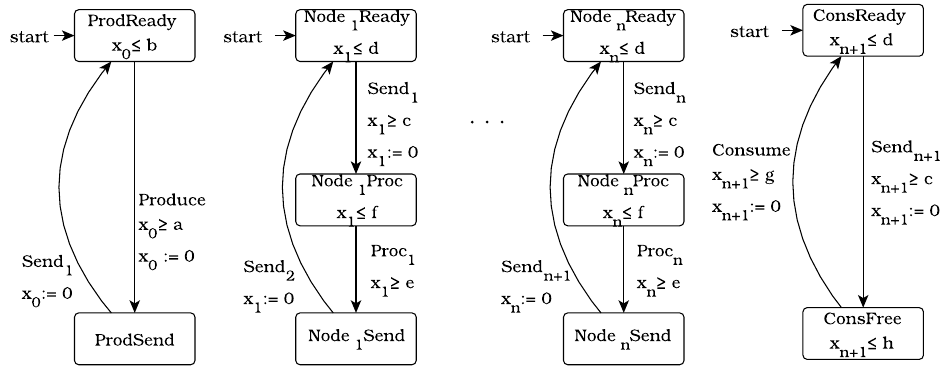
Figure 8. The TGPP